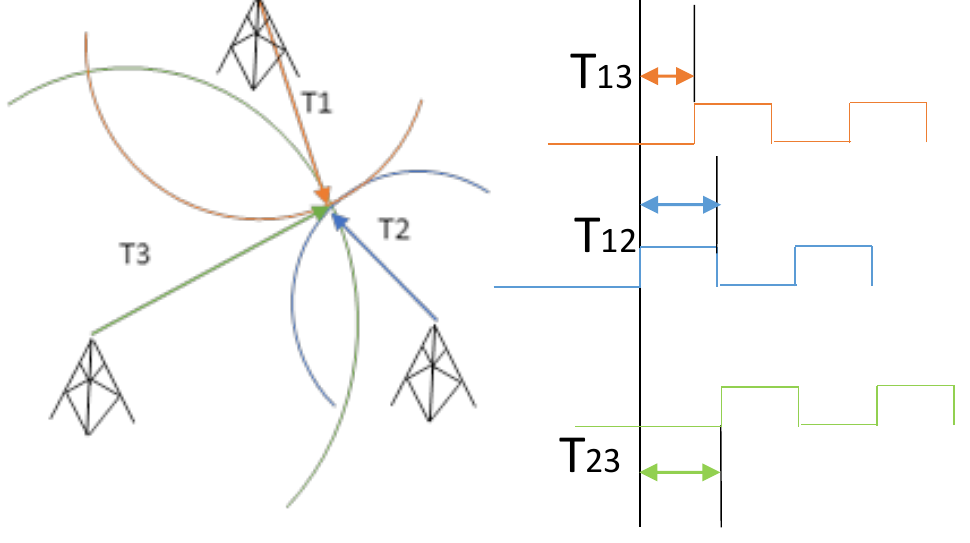
Figure 4. OTDOA position tracking in